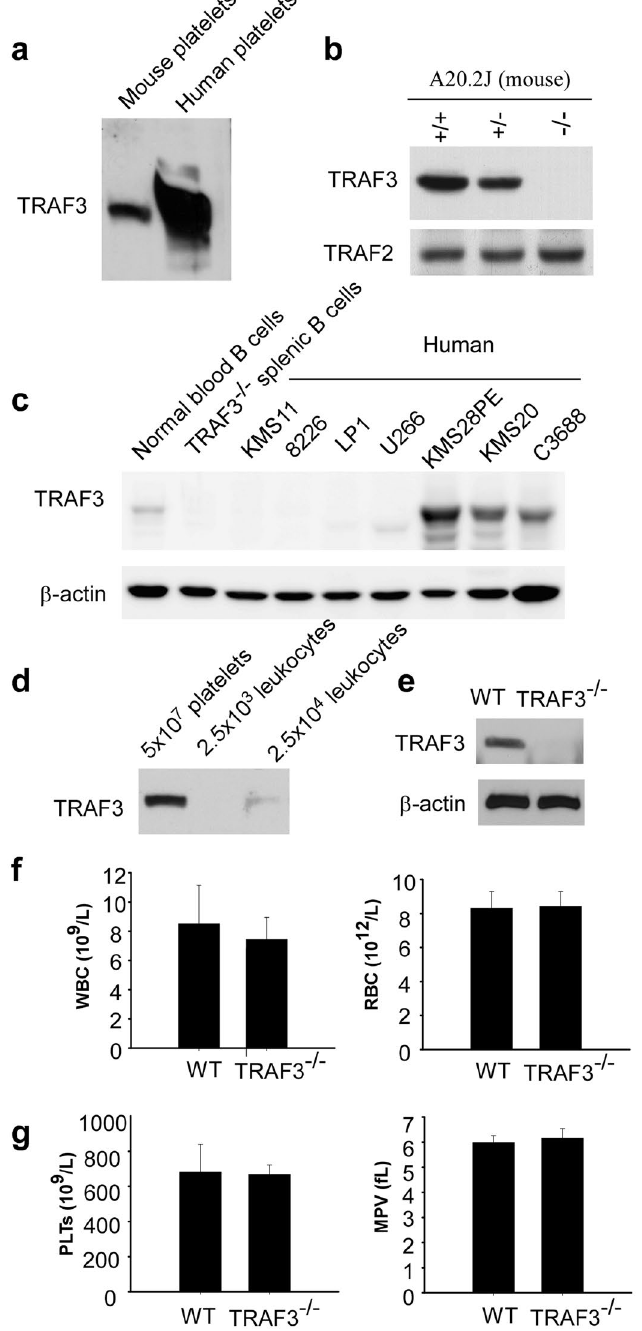
Figure 1. TRAF3 is expressed in platelets. ( a ) TRAF3 in human and mouse platelet lysates (5 × 10 7 platelets/ lane) was detected by Western blot with polyclonal anti-TRAF3 antibody. ( b ) Validation of the TRAF3 antibody using TRAF3 − / − mouse B cell line A20.2 J lysates in Western blot. Protein samples were immunoblotted for TRAF3, stripped, and reimmunoblotted for TRAF2. ( c ) Validation of the TRAF3 antibody using TRAF3- deficient human patient-derived multiple myeloma cell lines in Western blot. Human cell lines examined include two cell lines with TRAF3 bi-allelic deletions (KMS11 and 8226), two cell lines with TRAF3 frameshift mutations (LP1 and U266), two cell lines with cIAP1/2 bi-allelic deletions and wild type TRAF3 (KMS28PE and KMS20), and an EBV-transformed B lymphoblastoid cell line with wild type TRAF3 (C3688). Protein samples were immunoblotted for TRAF3, stripped, and reimmunoblotted for actin. ( d ) TRAF3 in lysate of mouse platelets (5 × 10 7 ) and lysates of leukocytes (2.5 × 10 3 and 2.5 × 10 4 , respectively) was detected by Western blot with polyclonal anti-TRAF3 antibody. ( e ) TRAF3 in platelet lysates of TRAF3 + / + and TRAF3 − / − mice was detected by Western blot. All the experiments were repeated at least three times. ( f ) White blood cell counts and red blood counts in TRAF3 + / + and TRAF3 − / − mice (n = 4 for each group). ( g ) Platelet counts and size of TRAF3 + / + and TRAF3 − / − mice (n = 4 for each